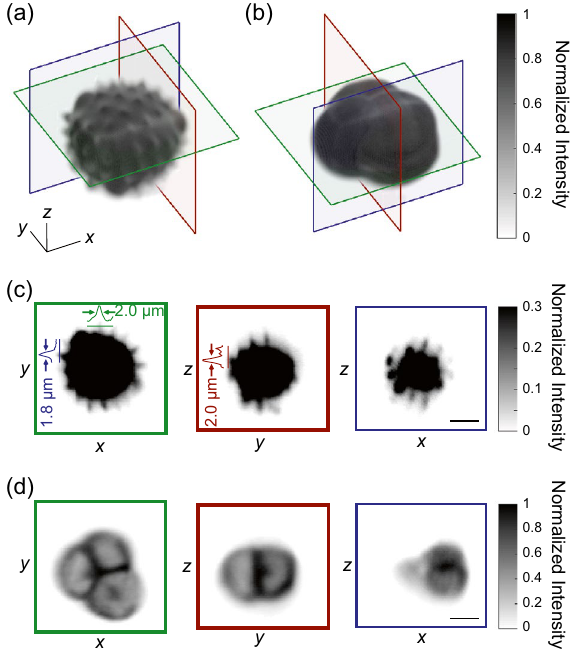
Figure 3. SCAPE imaging of pollen grains showed detailed substructure within each grain. ( a , b ) Three- dimensional images of two different pollen grains show different details. The pollen in ( a ) showed small spikes on the surface, while the pollen in ( b ) showed the smooth surface of a multi-grain conglomeration. ( c ) Projections along Cartesian planes were color matched to the planes in ( a ). Each projection showed the sharp, micrometer sized spikes on the surface of the pollen. Color profiles along sharp features are plotted on top of the individual projections. ( d ) Projections along Cartesian planes are color matched to the planes in ( b ). Each projection showed the internal boundaries between the multiple grains. Scale bars and axes all represent 10 µm. The excitation power was 1.0 mW after the excitation objective, the distance between planes was 0.25 µm, and the frame acquisition time was 30